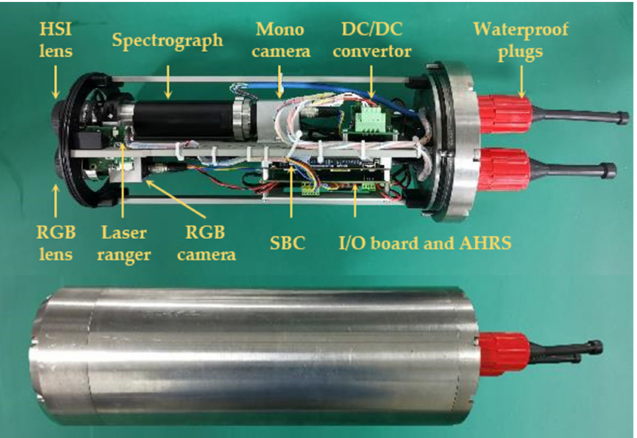
Figure 1. The prototype and encapsulated structure of the UHI system. The prototype includes the imaging subsystem (hyperspectral imager and RGB camera), sensing modules (laser ranger and IMU unit), and control unit (DC/DC convert, SBC, and I/O board) installed in the pressure-tight